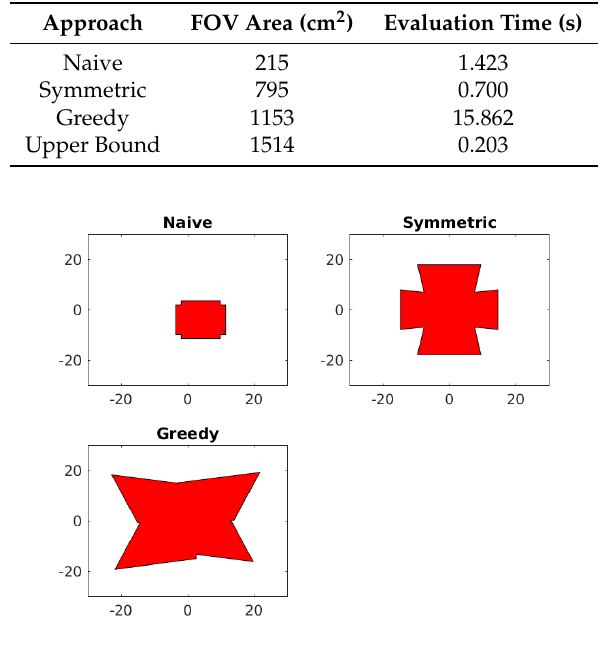
Figure 10. The resulting field of view of the three approaches used for the grid based camera array.